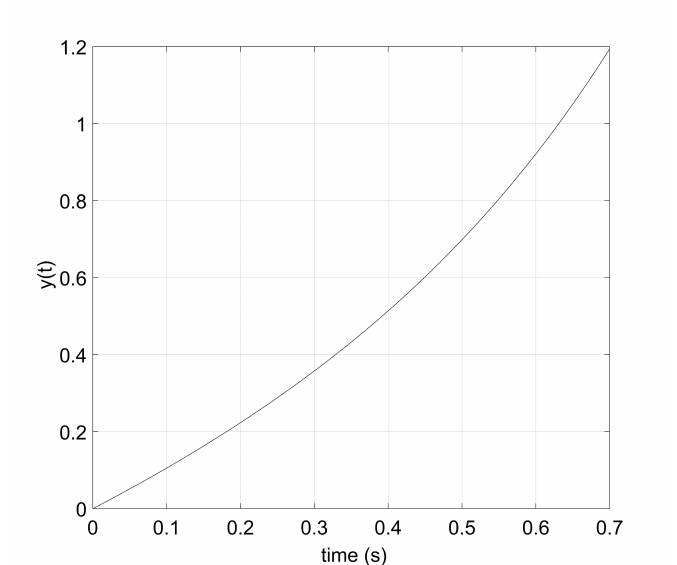
Figure 4. Curve obtained by recurrent method.